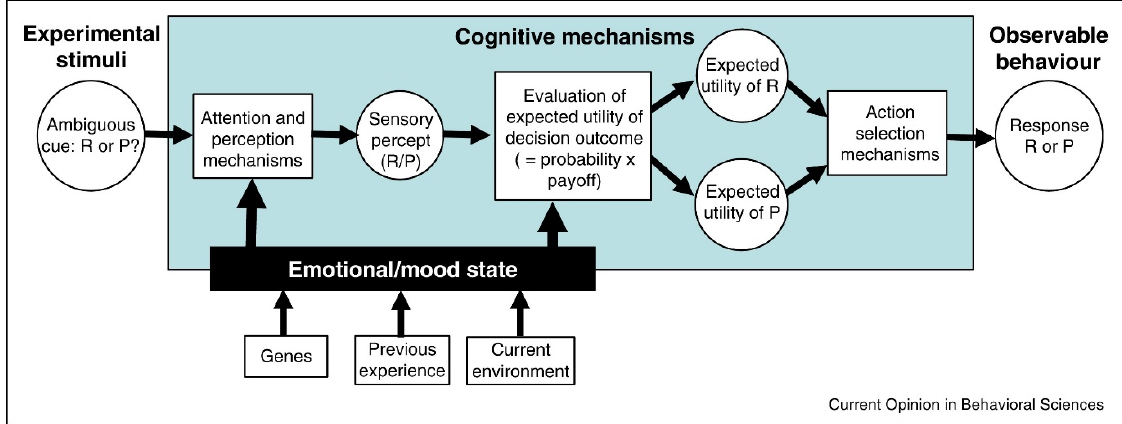
Figure 2. The cognitive mechanisms involved when an individual respond to an ambiguous cue in a judgement bias task. Emotional states or moods may modulate attention to cues (From [11]).